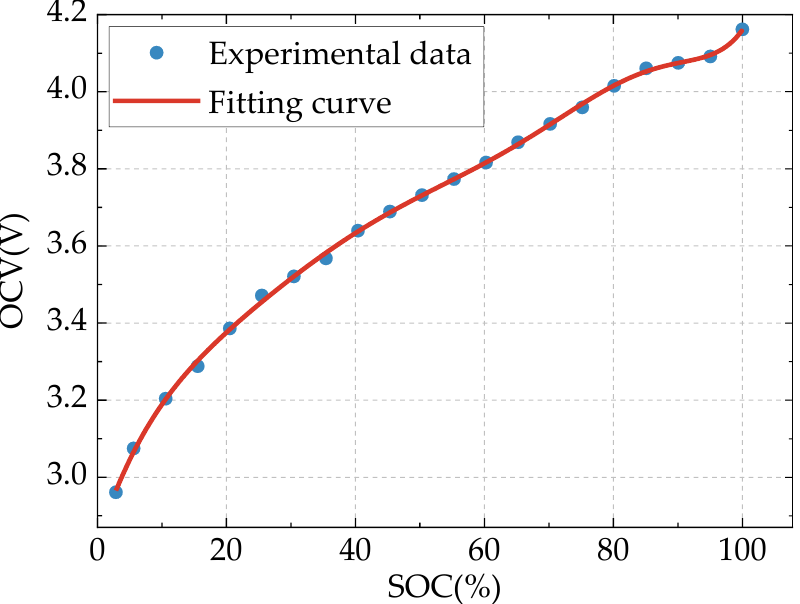
Figure 8. Experimental data and fitting curve of OCV–SOC. Based on the mathematical form of the second-order RC equivalent circuit model de- rived above, online parameter identification is performed with the data of UDDS operating conditions as input. The five parameters (R 0 , R 1 , R 2 , C 1 , C 2 ) as identified by the FFRLS online are shown in Figure 9.